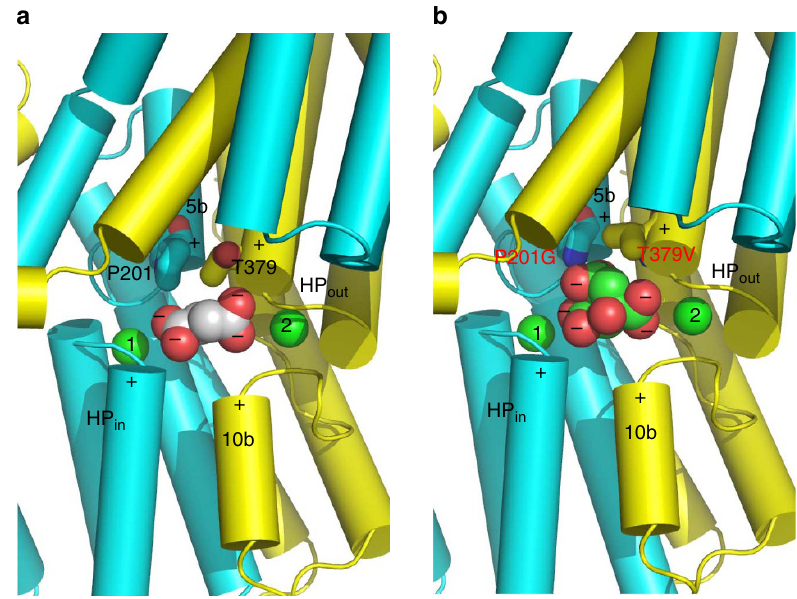
Figure 8 | Structural basis for substrate recognition by DASS. The N and C domains in VcINDY ( a ) and MT5 ( b ) are coloured cyan and yellow, respectively. Relevant amino acids are drawn as stick models, whereas the bound succinate ( a ) or citrate ( b ) as well as the Na þ ions (green) are shown as spheres. Positive helix dipoles are highlighted by plus signs, whereas the negatively charged carboxylates in succinate or citrate are indicated by minus signs. The charged state of succinate or citrate is deduced based on the crystallization pH ( B 7). Both the helix dipoles and Na þ appear to contribute to the anion binding. Furthermore, P201 and T379 may enable VcINDY to select for succinate but against citrate. In MT5, P201 and T379 are replaced by Gly and Val, respectively, which may allow the membrane-embedded transporter to bind citrate more strongly than